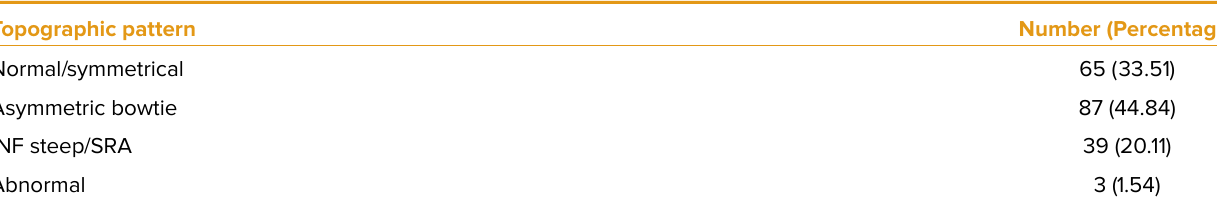
Table 3. Topographic patterns of 194 eyes of 97 patients Topographic pattern